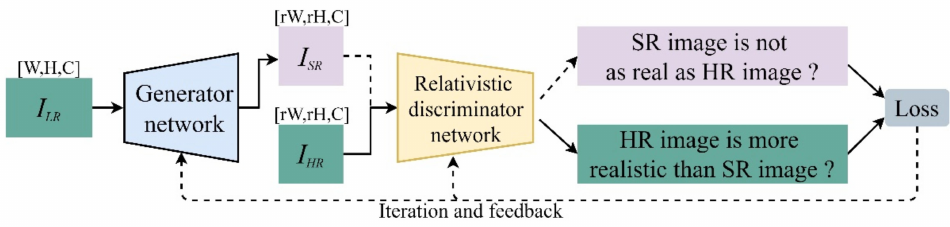
Figure 1. Schematic diagram of the super-resolution image processing in TE-SAGAN.